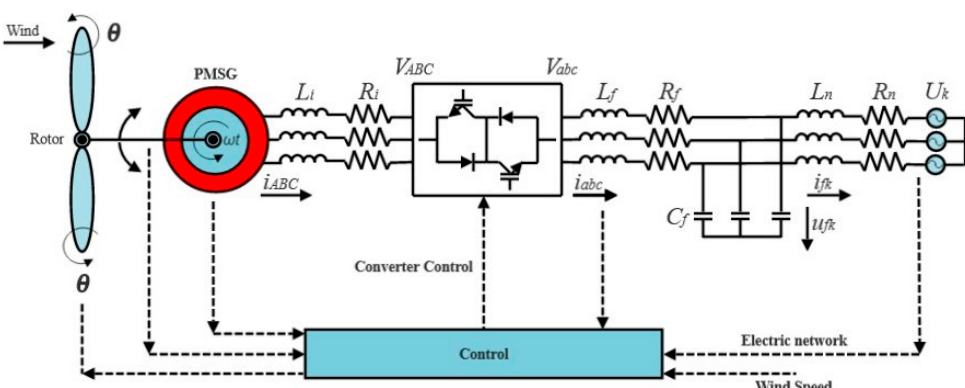
Figure 18. Matrix converter connected between PMSG and grid.